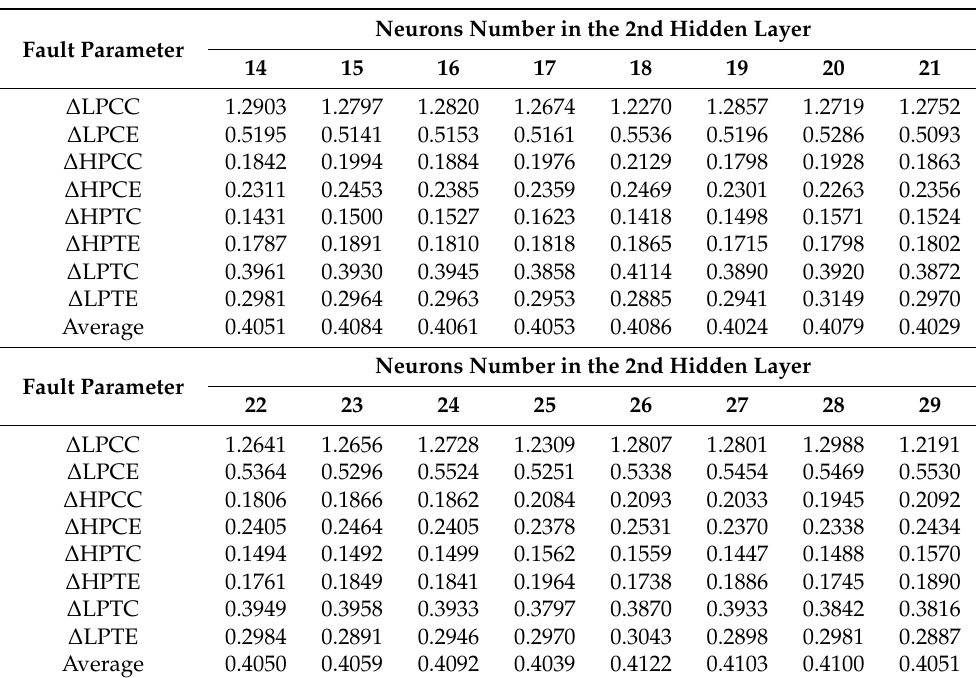
Table 9. Selection of optimal neurons number (turbo fan, extended model). Fault Parameter